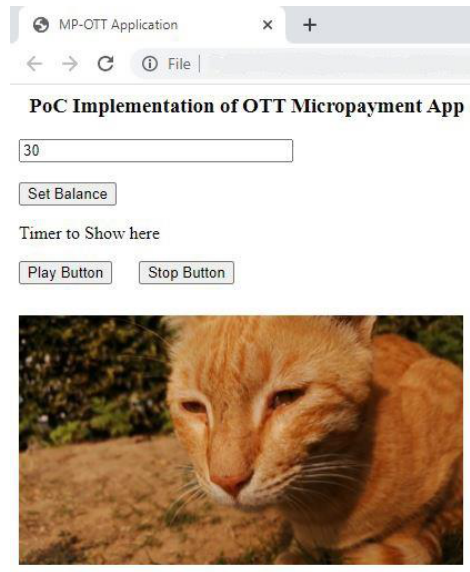
Figure 17. MP-OTT platform dashboard.